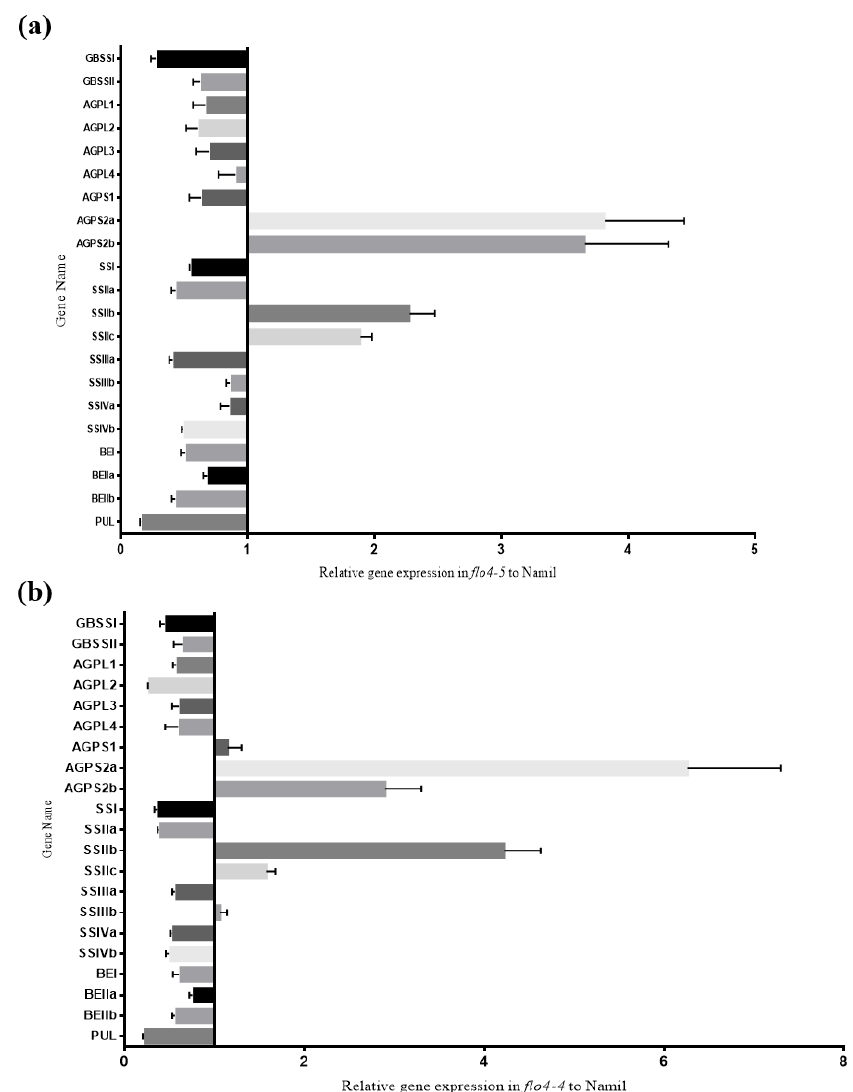
Figure 5. Expression profiles of the genes involved in production of storage starch in endosperm from the flo4-5 mutant ( a ) and Suweon542 ( b ) with the wild type Namil (bar begin with 1). Reference gene was Actin, and the expression levels of these genes are shown relative to the wild type Namil, which is set as 1. Each gene name is indicated by a simplified representation. GBSSI and GBSSII , granule bound starch synthase I and II; AGPL ( AGPL1 , AGPL2 , AGPL3 and AGPL4 ) and AGPS ( AGPS1 , AGPS2a and AGPS2b ), ADP-glucose pyrophosphorylase large subunit and small subunite, respectively; SSIIa and SSIIIa , soluble starch synthase IIa and IIIa , respectively; BEI and BEIIb , branching enzyme I and IIb , respectively; PUL ,